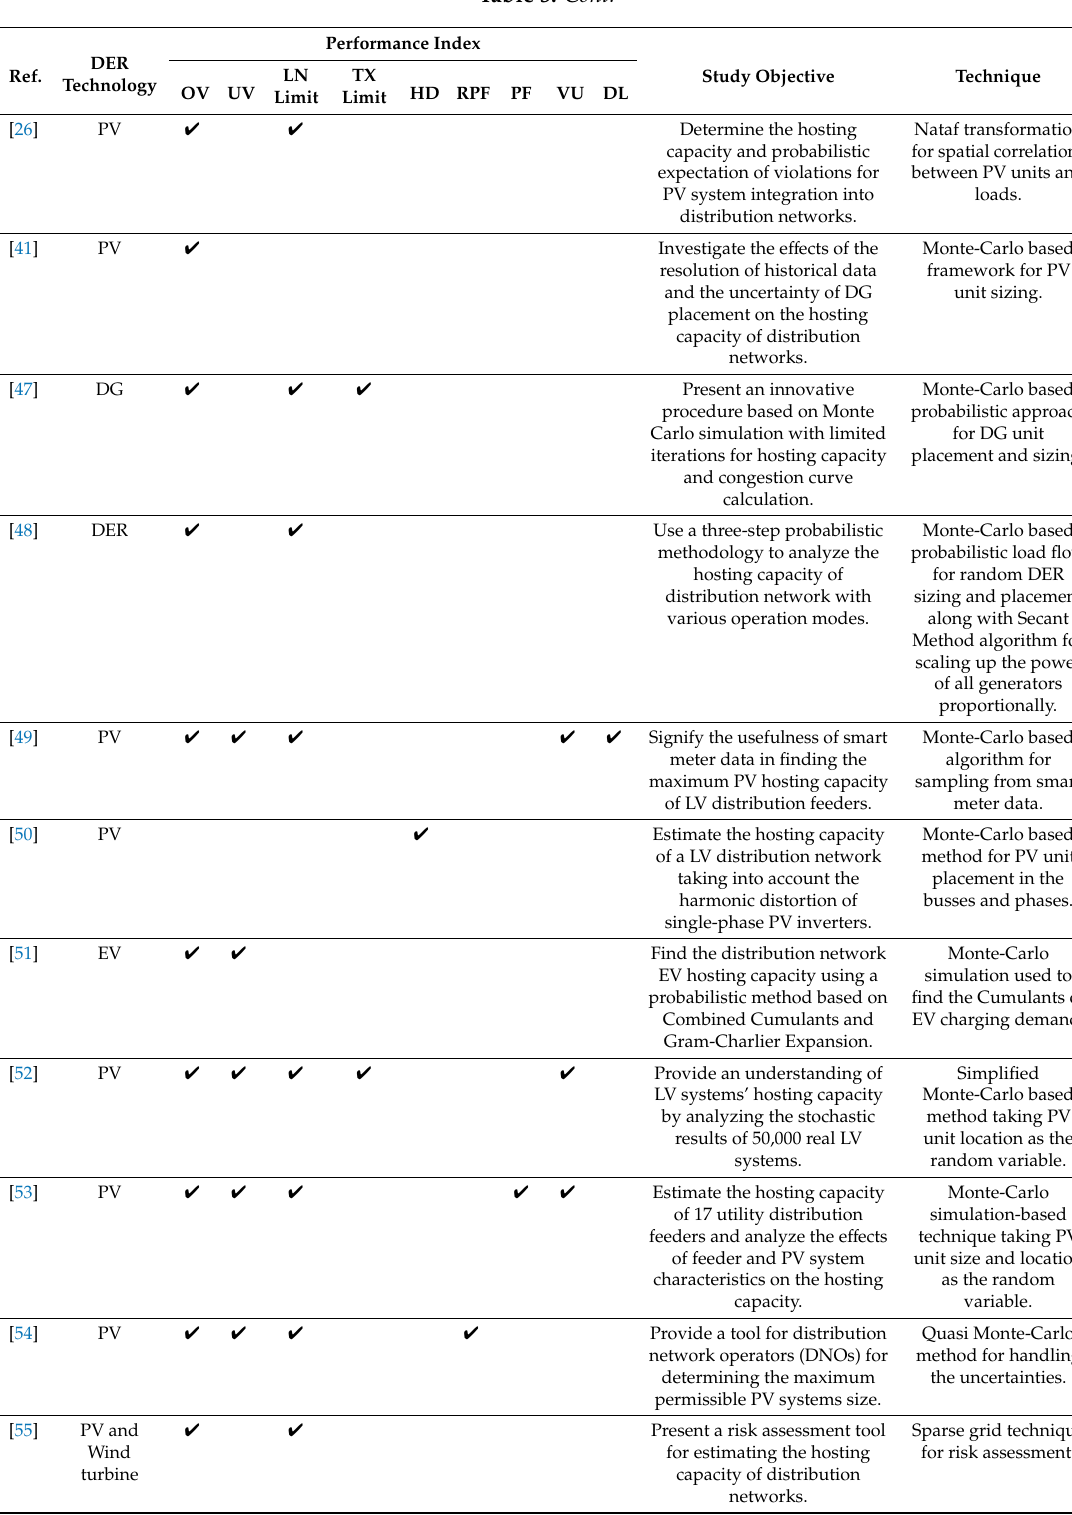
Quasi Monte-Carlo method for